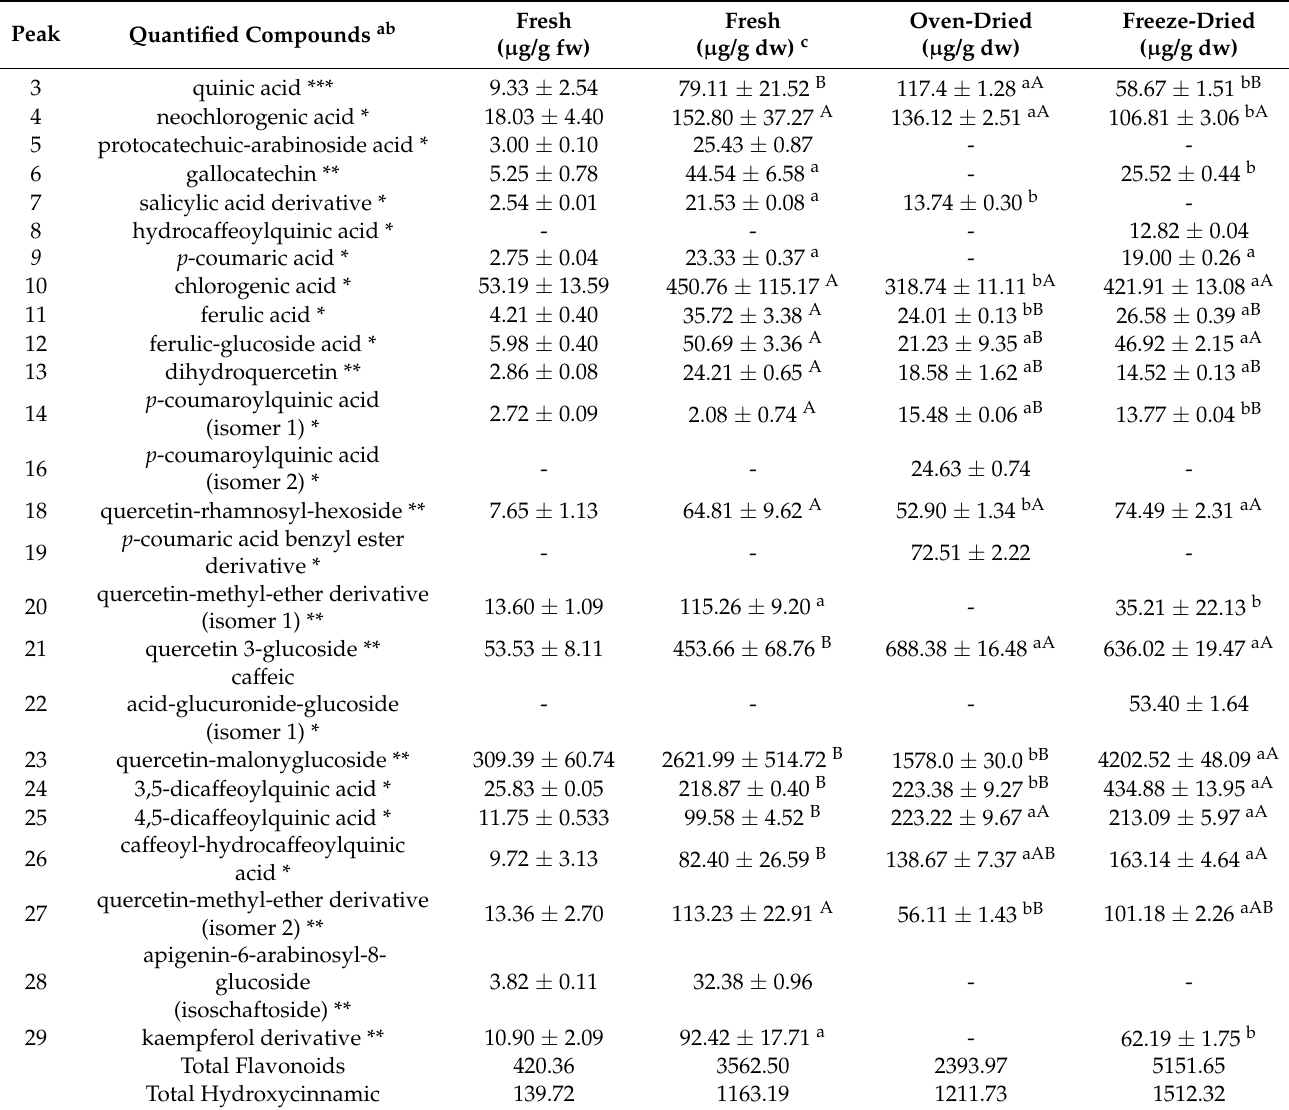
Table 4. Quantification of phenolic compounds in the fresh, oven-dried, and freeze-dried extracts of S. ramosissima